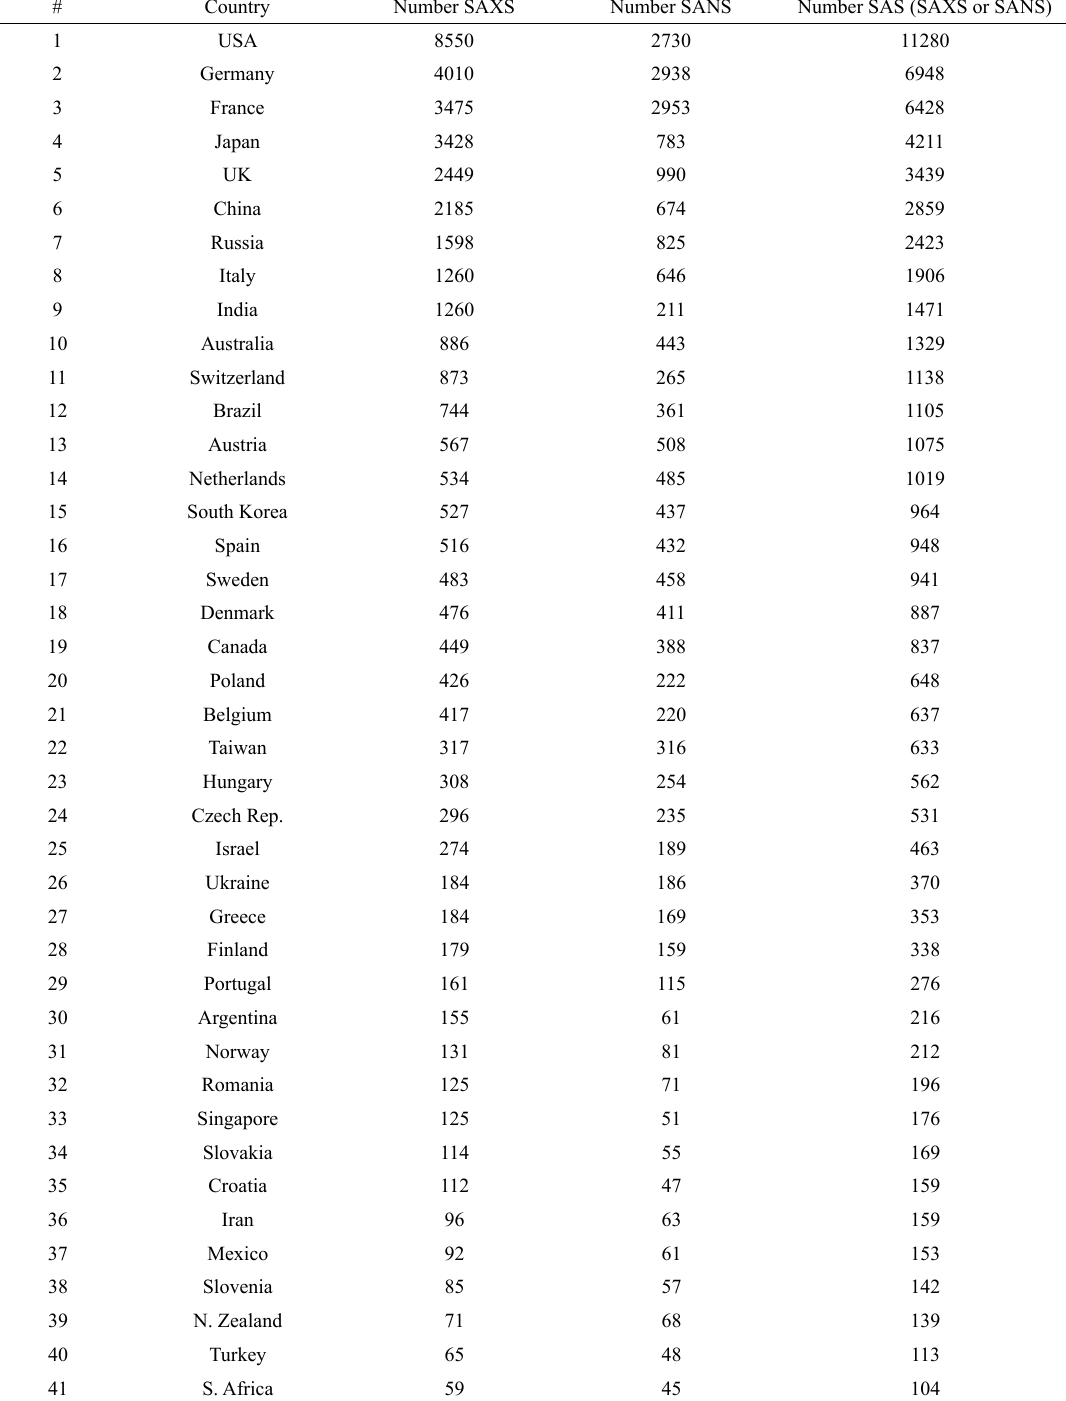
Table 1. Total numbers of articles published by authors from different countries related to SAXS, SANS and SAS (either SAXS or